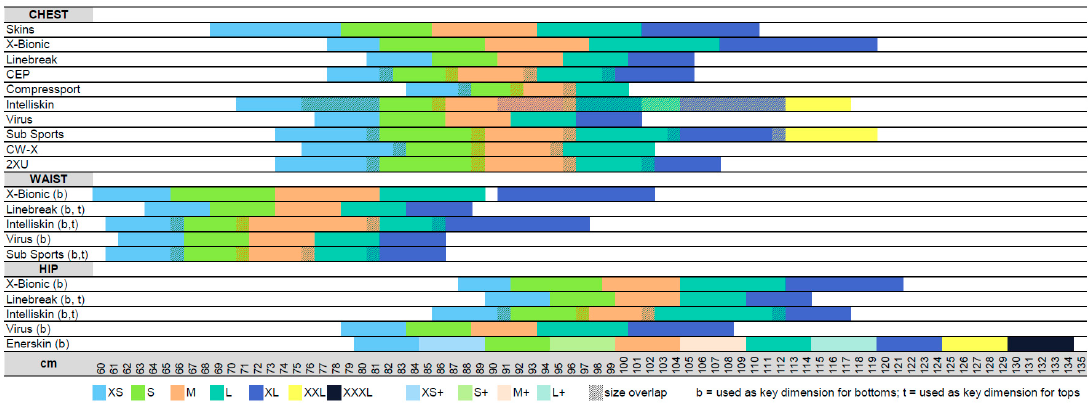
Figure 1. Chest, waist and hip circumference measurements (cm) used for women’s sports compression garment (SCG) size